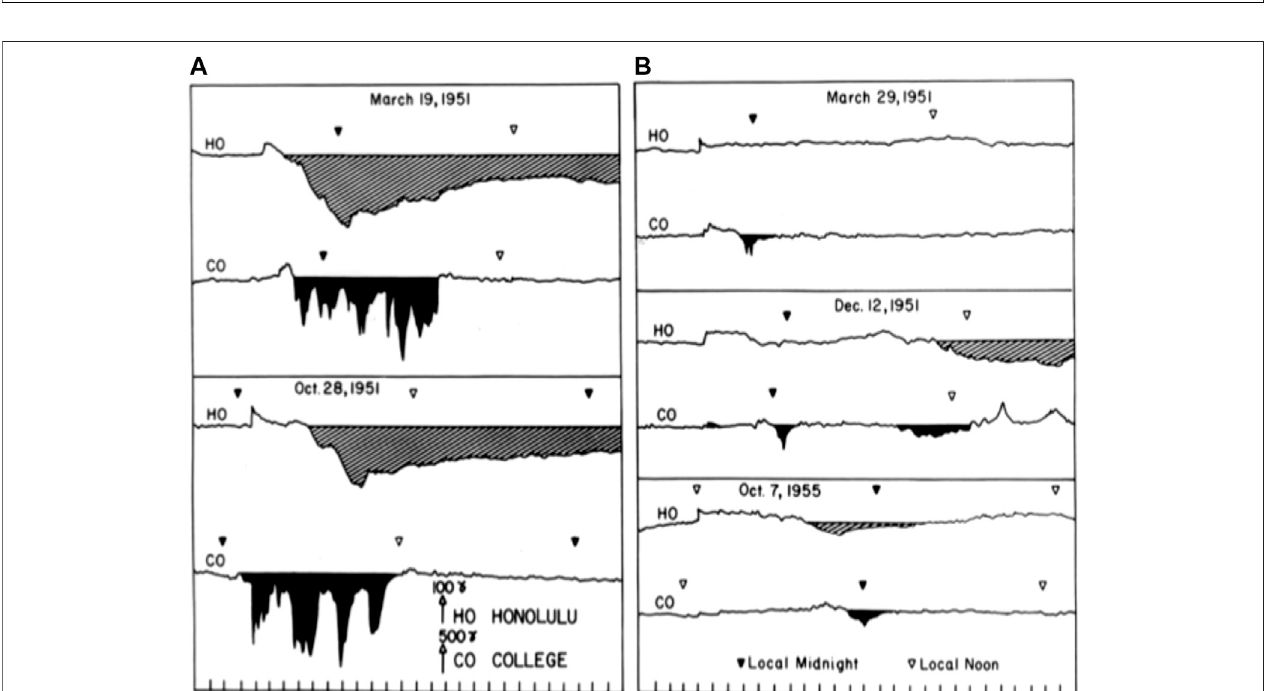
FIGURE3| Acomparisonoftheintensityofintense (A) andweak (B) mainphaseswithasimilarintensityofthessc(indicatingsimilarintensitiesofthesolarwind).It showed also that an intense main phase (Ho, Honolulu) is accompanied by intense polar magnetic disturbances (CO, College), and weak main phases are hardly accompanied by polar magnetic disturbances (Akasofu and Chapman, 1963b).